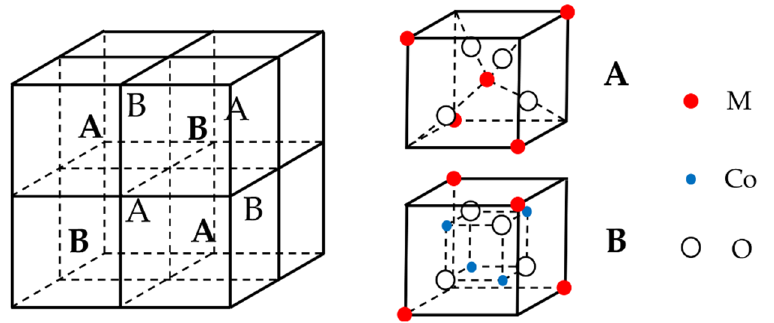
Figure 4. Schematic crystal structure of MCo 2 O 4 .